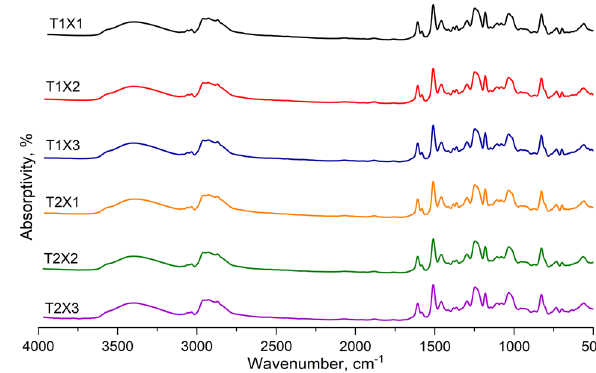
Figure 4: Infrared spectrum of the specimen after quenching with various